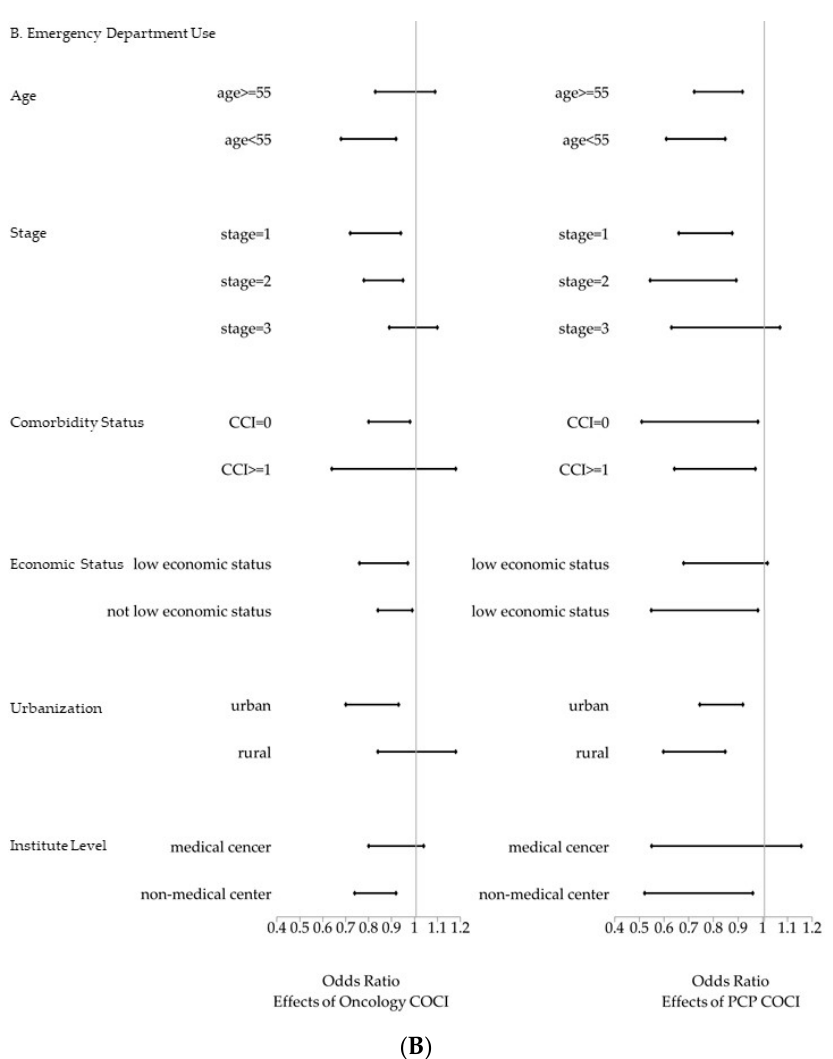
Figure A1. Subgroup analysis of odds ratio between the high COCI and low COCI groups for health events of ( A ) all-cause hospitalization and ( B ) all-cause emergency department use.